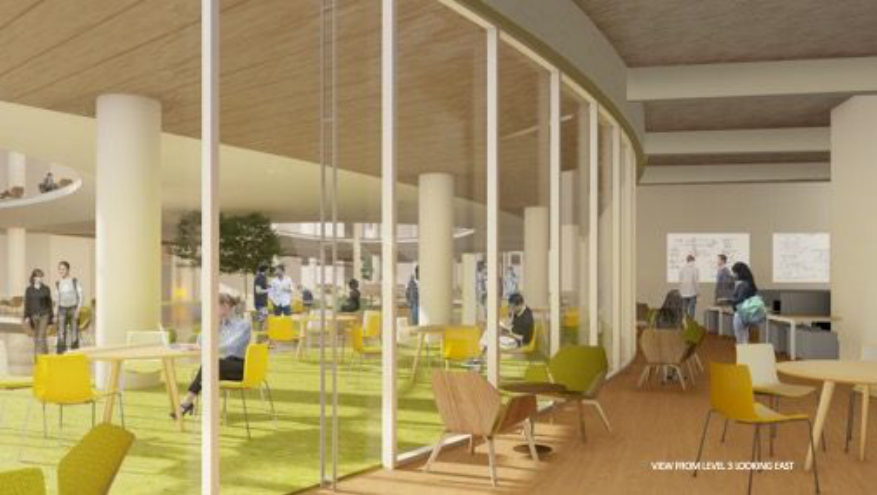
Figure 3. View of unstructured interaction space for